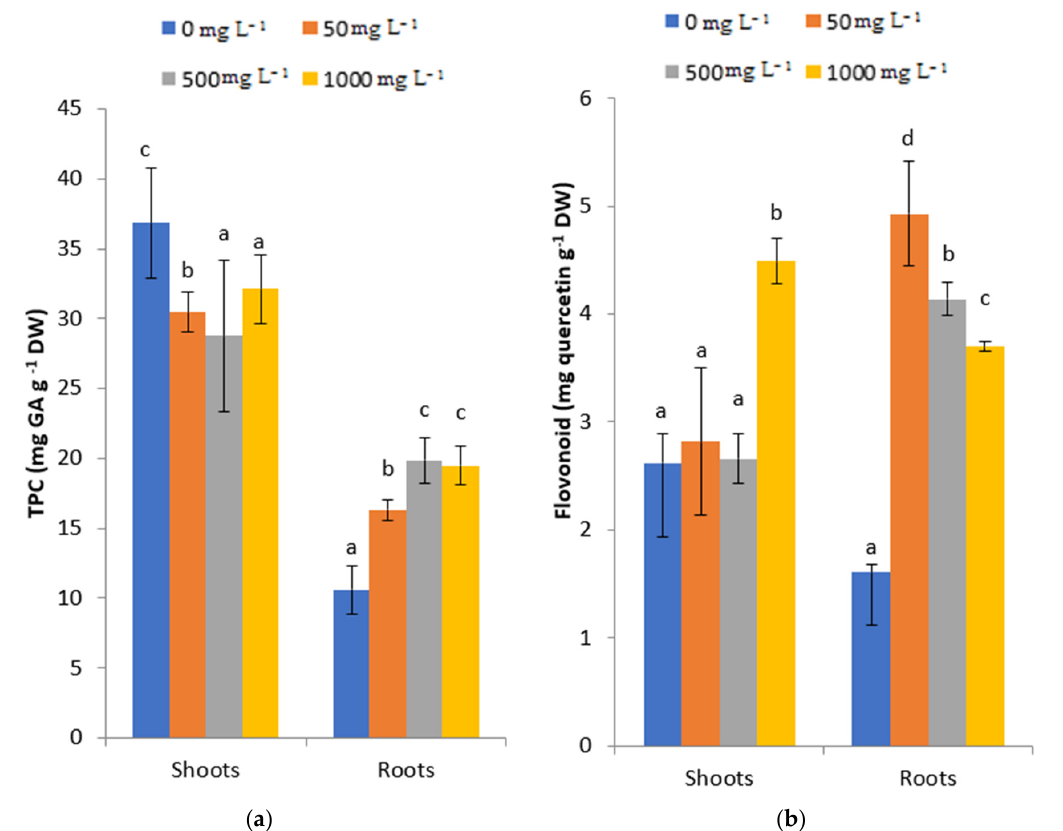
Figure 6. Variation of TPC ( a ) and flavonoid ( b ) contents in roots and shoots of fenugreek after three months of (0, 50, 500, 1000 mg L − 1 ) PbCl 2 treatments. All the values are means of triplicates ± SD. ANOVA is significant at p < 0.05. Different letters indicate significantly different values in a particular tissue of fenugreek under different treatments (DMRT, p < 0.05).